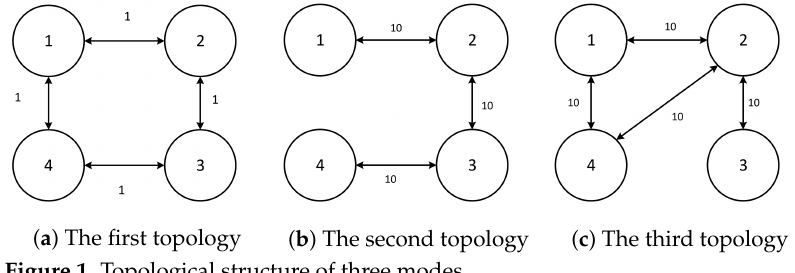
Figure 1. Topological structure of three